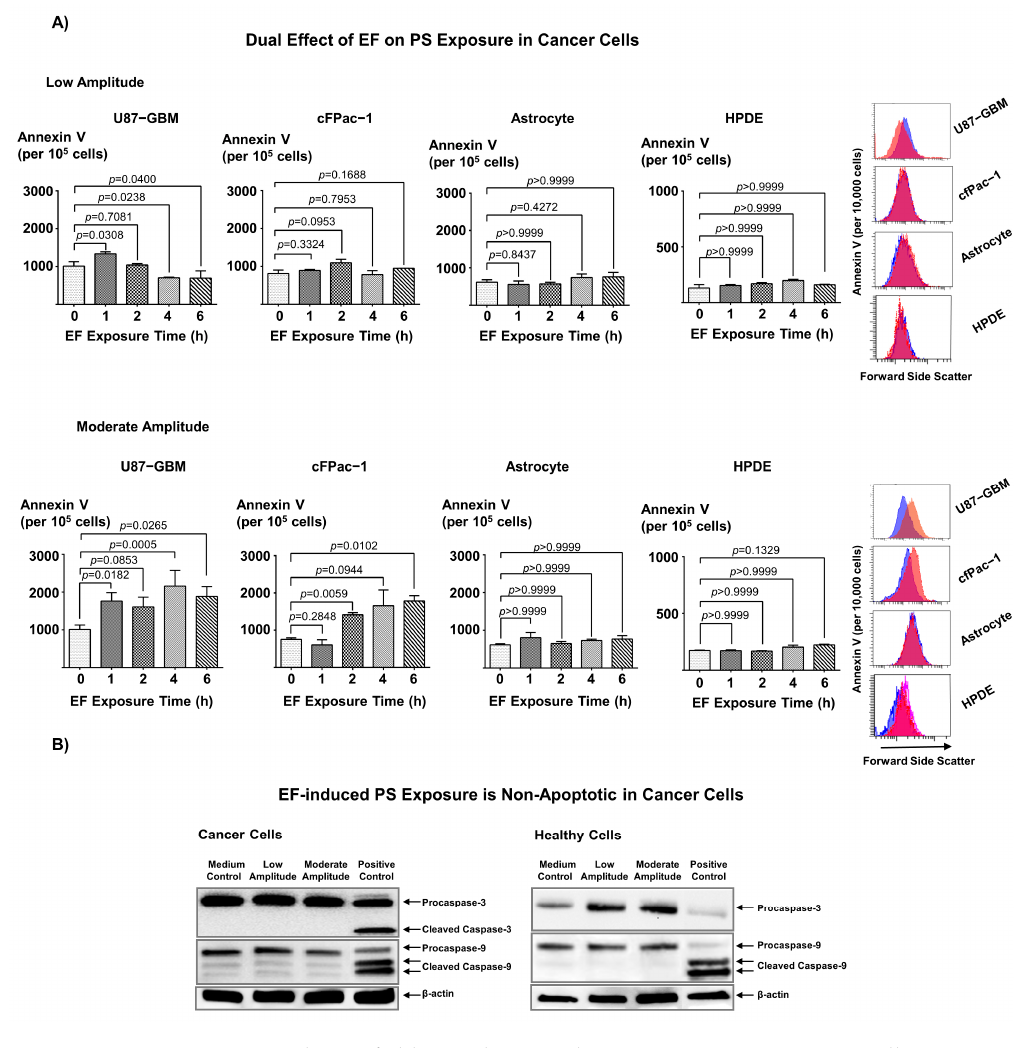
Figure 2. Electric field stimulation induces PS exposure in cancer cells via caspase-independent mechanism. ( A ) Flow cytometric measurements of annexin V (FITC Fluorescence) demonstrate a significant decrease or no change in cell PS exposure in U87-GBM (top first panel) and cfpac-1 (top second panel) cancer cells following low amplitude EF (top panel) for 4–6 h, whereas moderate amplitude EF (bottom panels) stimulation significantly increased the PS exposure in U87-GBM (bottom first panel) and cfpac-1 (bottom second panel). This effect is absent in healthy astrocytes (top third, bottom third panels) and HPDE cells (top fourth, bottom fourth panels). The top and bottom fifth panels show representative histograms, with blue denoting Control and red indicating the EF-treated groups (6 h). Sample size (n) = 3 ( B ) Western blot analysis showed that 24-h EF stimulation did not change cleaved caspase 3 and 9 expressions in glioblastoma cells (U87-GBM) (left panel) or healthy cells (astrocytes) (right panel), with the levels in the stimulated group similar to the controls. Positive control: Cells were treated with 1 µM staurosporine for 4 h.